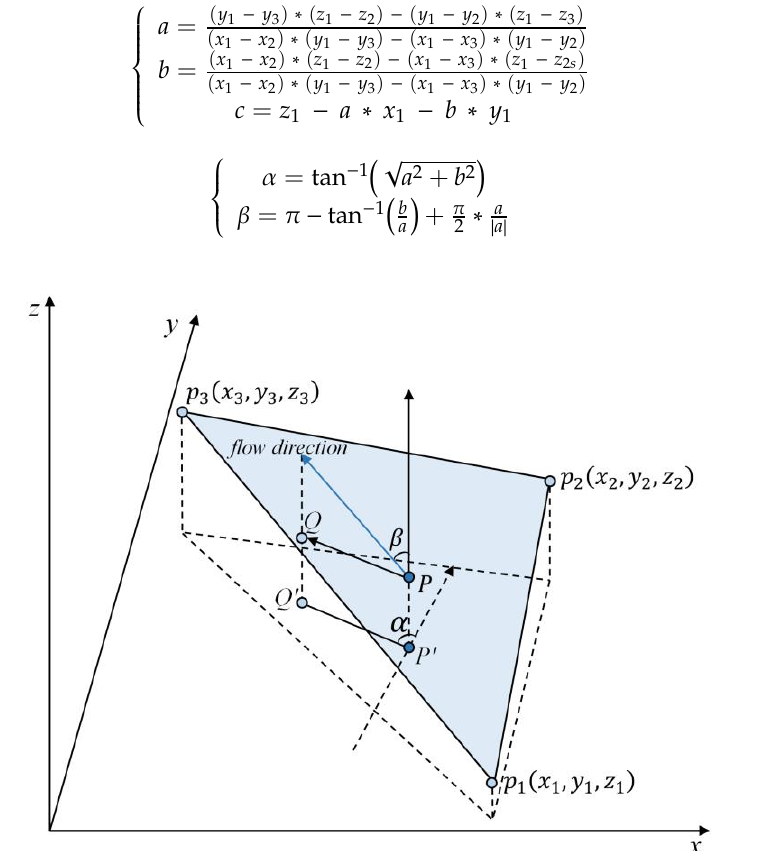
Figure 2. Flow direction over the triangular facet drawn from a random point.